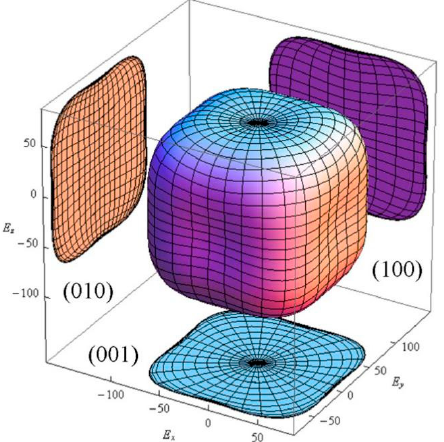
Figure 2. The three-dimensional Young’s modulus of CAO.